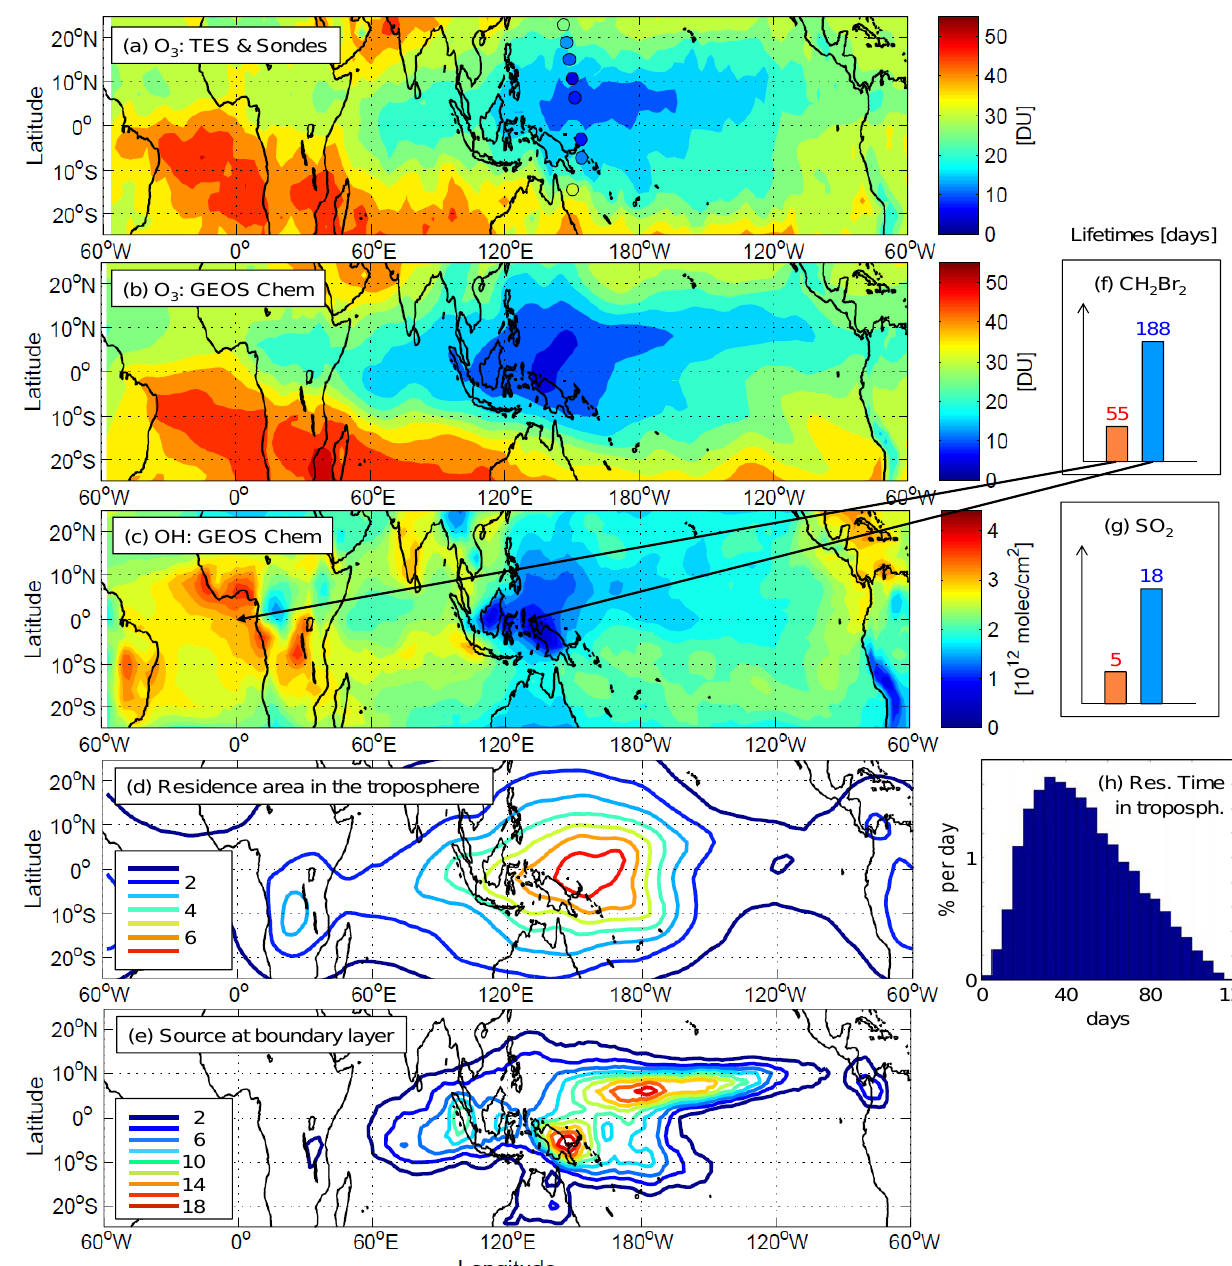
Fig. 4. Tropospheric ozone columns from (a) TES for October 2009 (results for 2005–2009 are similar, see Fig. 5), the sondes (open circles, dates see Fig. 1), and (b) GEOS Chem (mean 1–15 October 2009). (c) OH columns from GEOS-Chem (mean 1–15 October 2009). (d, e, h) show ATLAS 4-months backtrajectory runs for air entering the stratosphere (1 October–31 January). Average conditions for 2002– 2011, individual results for 2009 in Figs. 7 and 8. (d) Density distribution function of the horizontal positions of the trajectories between the boundary layer and the LCPs. (e) Density distribution function of the horizontal positions of the last contact with the boundary layer. The values in (d) and (e) are normalized such that a horizontally uniform distribution corresponds to a value of 1 at every grid point. (f–g) Examples of gas-phase lifetimes of relevant species in the mid-troposphere (500hPa) at the equator for typical conditions over the Atlantic (0 ◦ E, orange) and for conditions in the OH minimum (130 ◦ E, blue). (h) Distribution of residence times between last contact with the boundary layer and the LCP for trajectories ascending into the